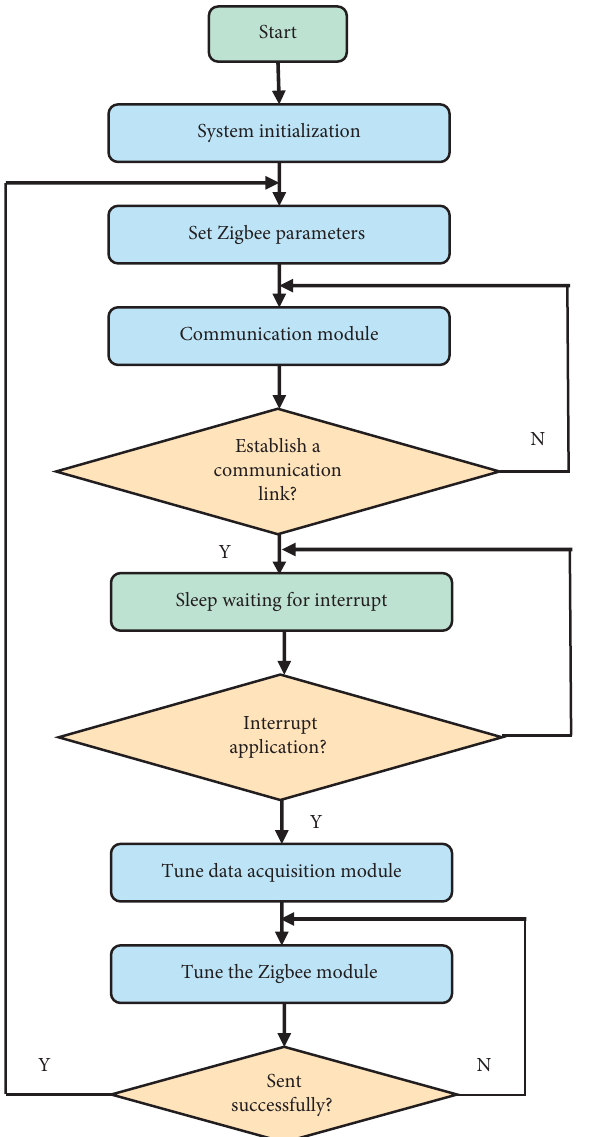
Figure 4: The main program design of the lower camera position.